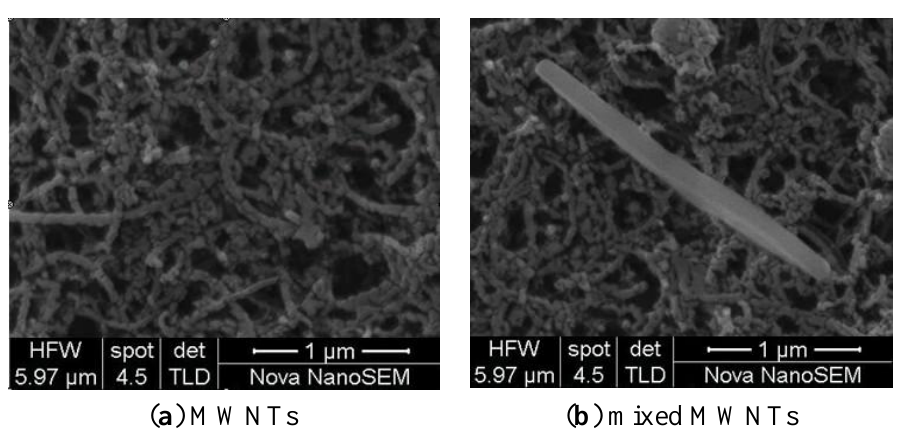
Figure 3. SEM images of